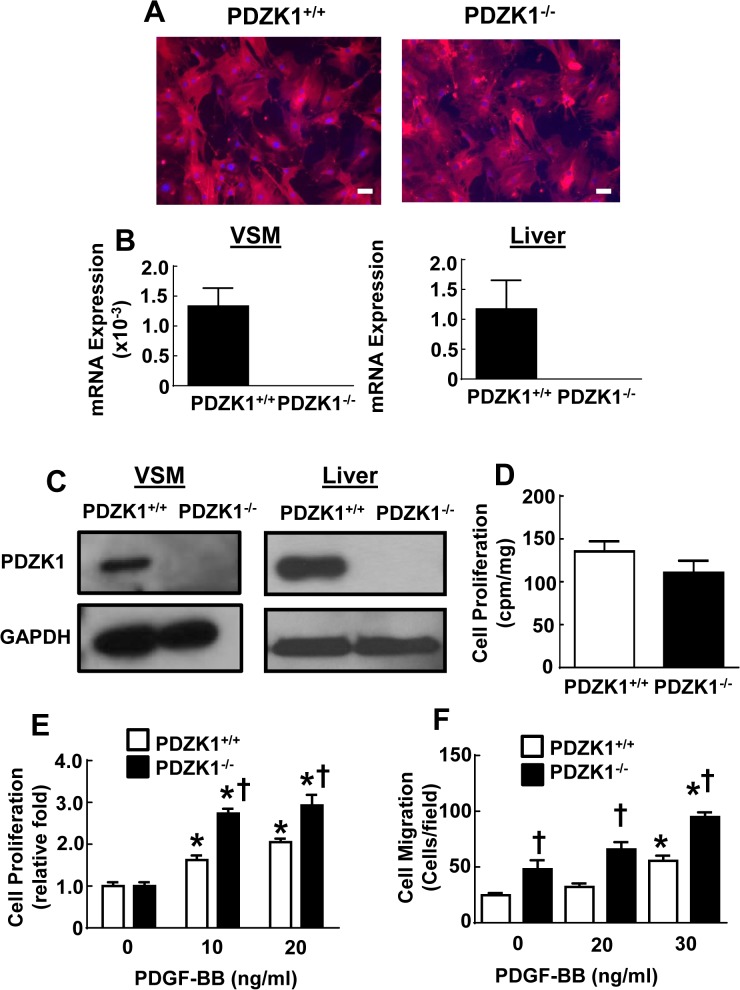
VSM cells from PDZK1-/- mice display enhanced PDGF-stimulated cell proliferation and migration.A. Aortic VSM cells were isolated from PDZK1+/+ or PDZK1-/- mice and immmunfluorescent staining was performed with anti-α-SMA monoclonal antibody (red). The scale bar indicates 100 μm. B. PDZK1 mRNA was quantified in VSM cells and liver from PDZK1+/+ and PDZK1-/- mice. Results are expressed relative to cyclophilin. C. PDZK1 protein expression was evaluated by immunoblotting using anti-PDZK1 polyclonal antibody. Equal protein loading was confirmed by immunoblotting using anti-GAPDH antibody. D. Cell growth under quiescent conditions was assessed by quantification of 3H-thymidine incorporation. E.Cell proliferation was evaluated in VSM incubated in the presence of 0–20 ng/ml PDGF-BB for 24h. F. Cell migration was assessed in VSM incubated in the presence of 0–30 ng/ml PDGF-BB for 4h. In B and D-F, values are mean±SEM, n = 3, *p<0.05 vs. no PDGF, †p<0.05 vs. PDZK1+/+.